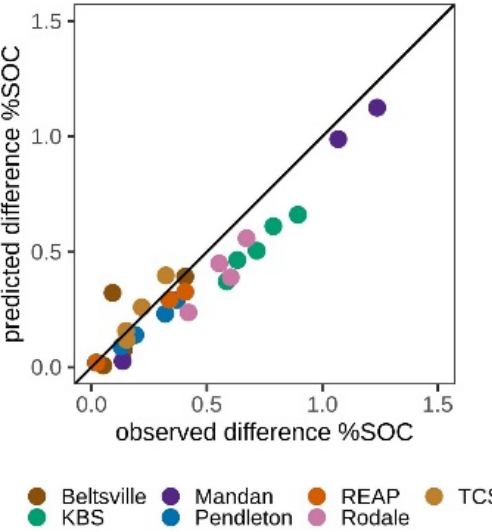
Figure 7. Observed versus EML predicted difference in SOC% between best management treatment and other treatments at each of the seven trials. At Mandan, the difference is between time points, not